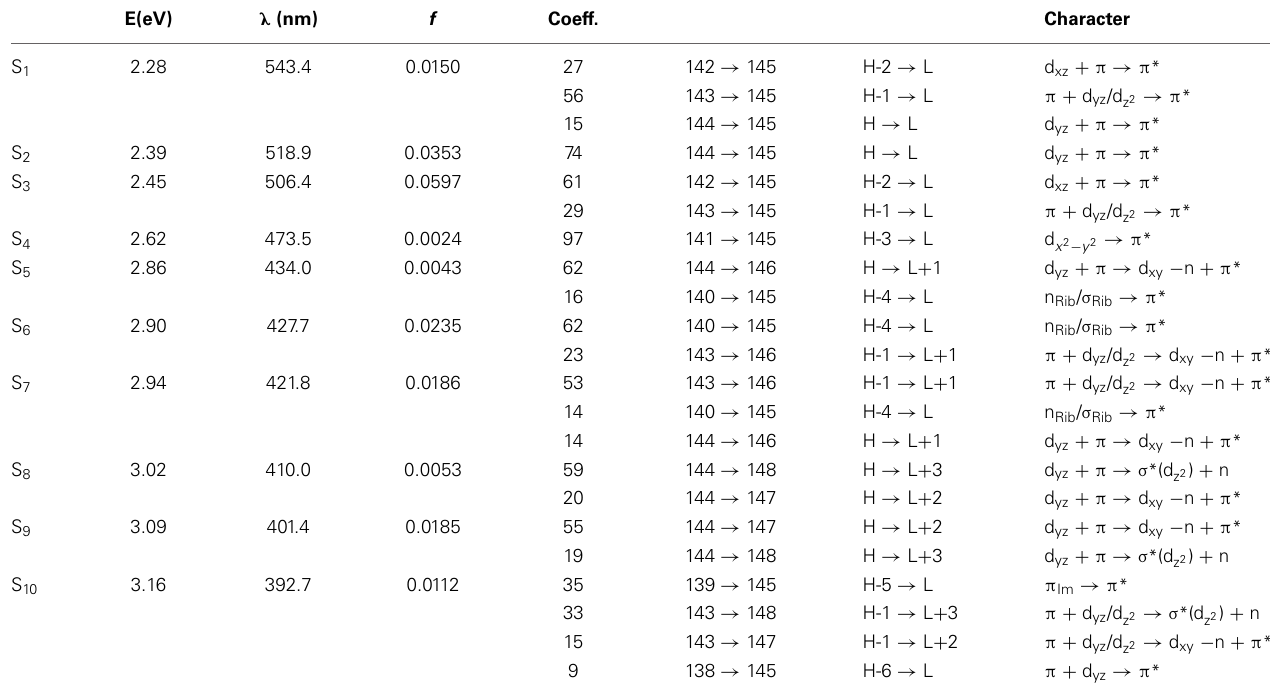
Table 3 | The lowest ten singlet states for RibCbl received from TDDFT/TZVP PCM (water)